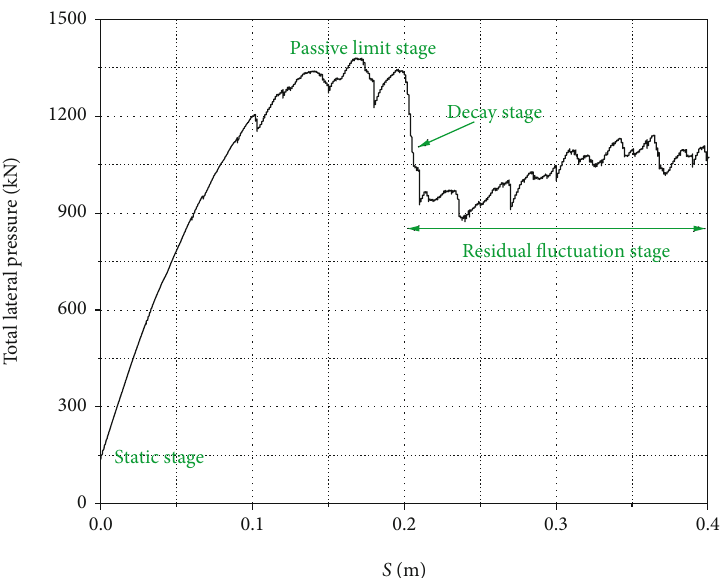
Figure 8: Total lateral pressure versus displacement of the wall.